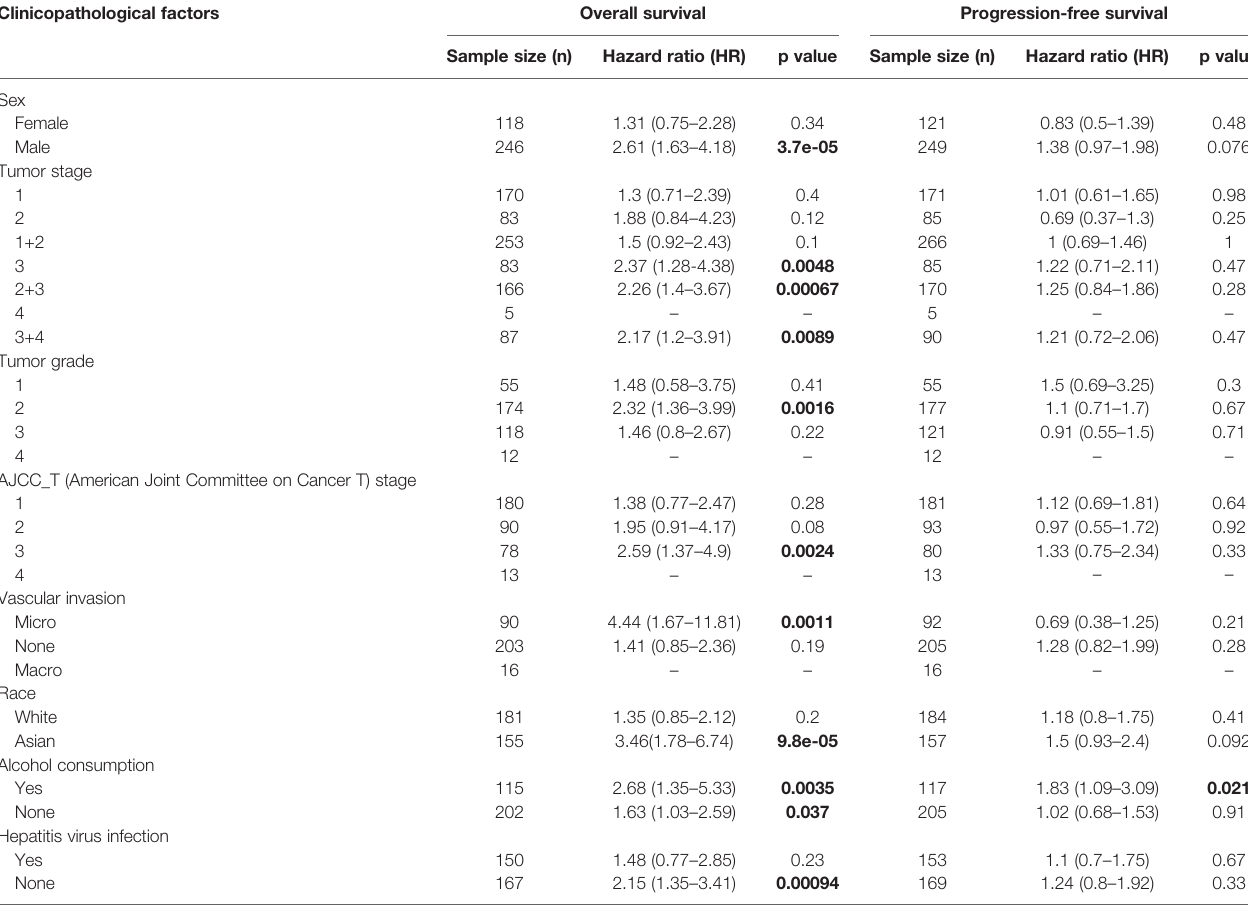
Bold values indicate P